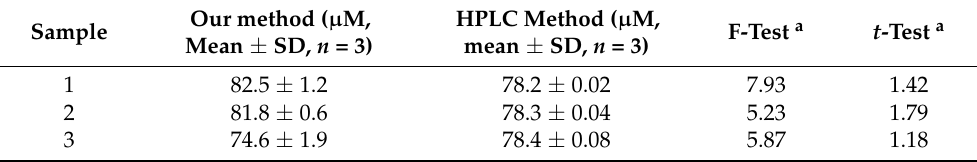
Table 1. Detection of AQ4N in mouse plasma.